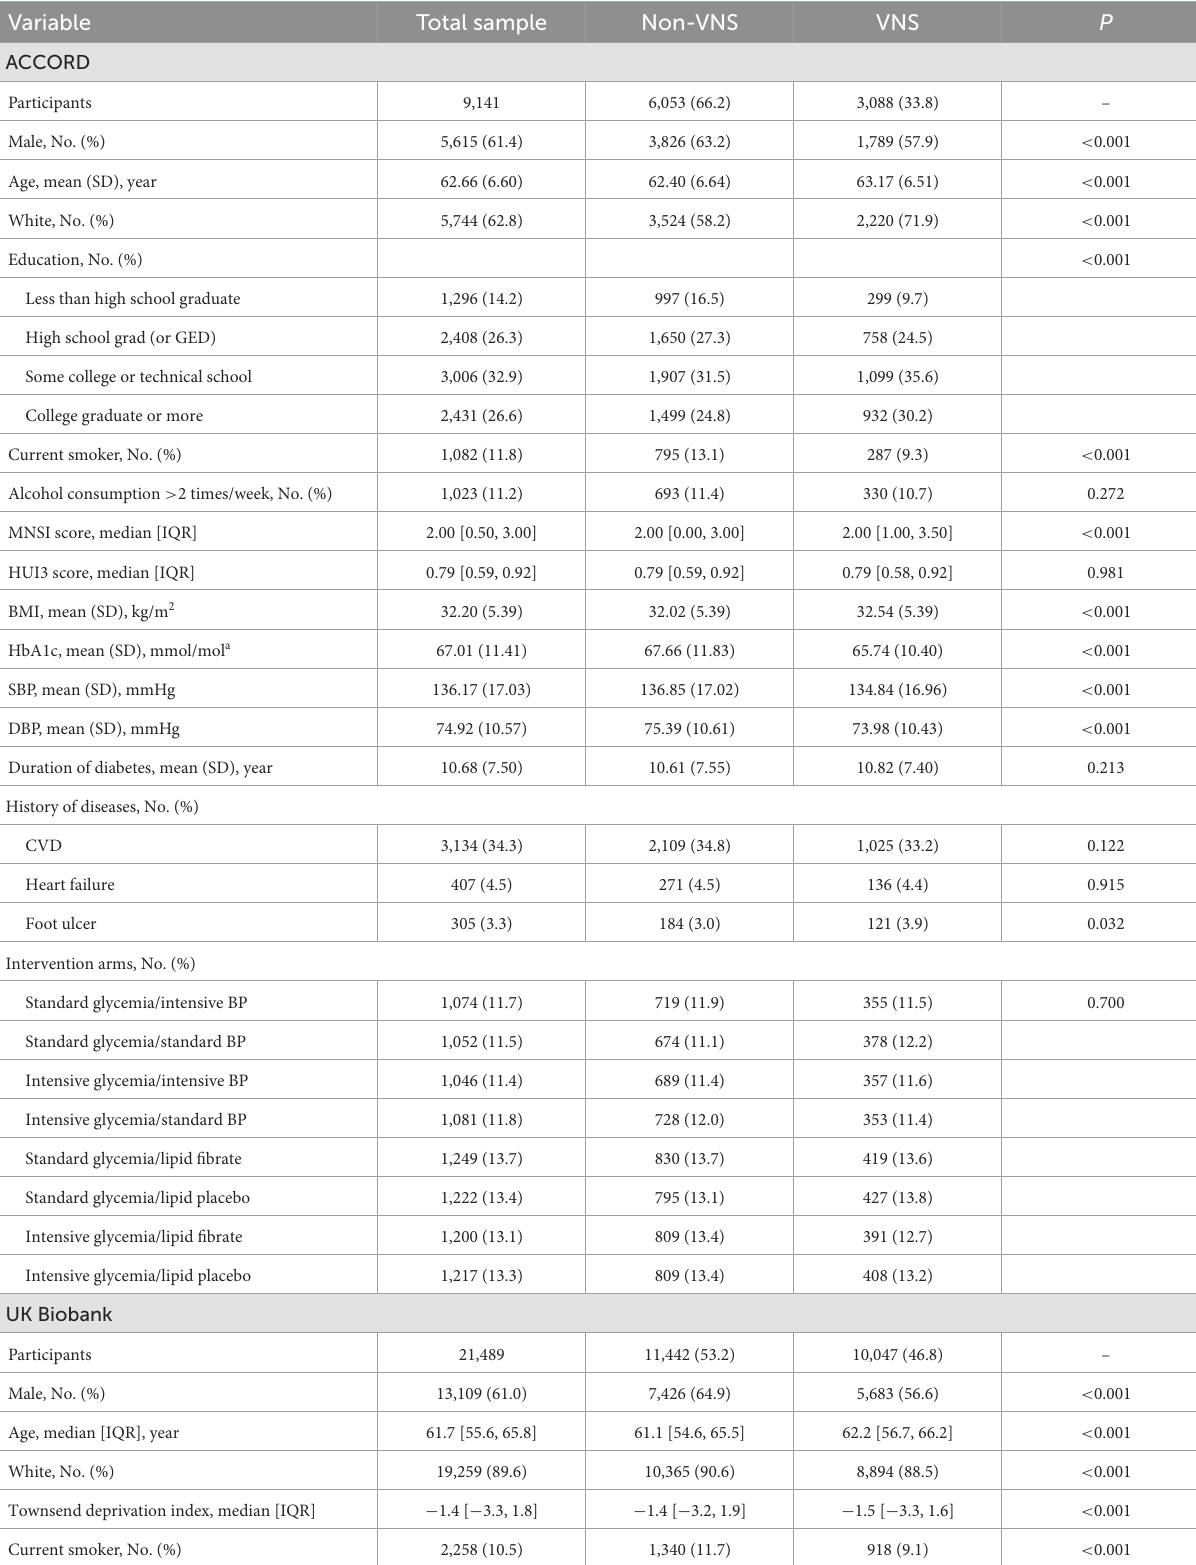
TABLE 1 Baseline characteristics of participants in ACCORD and UK